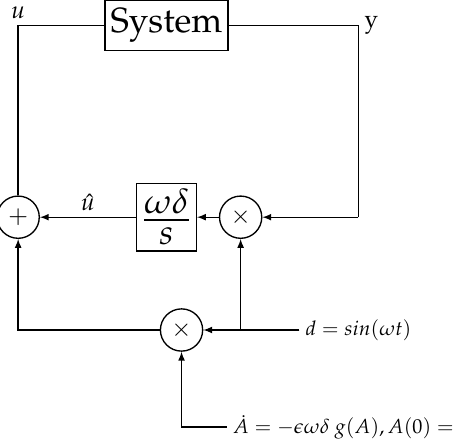
Figure 7. Extremum seeking feedback